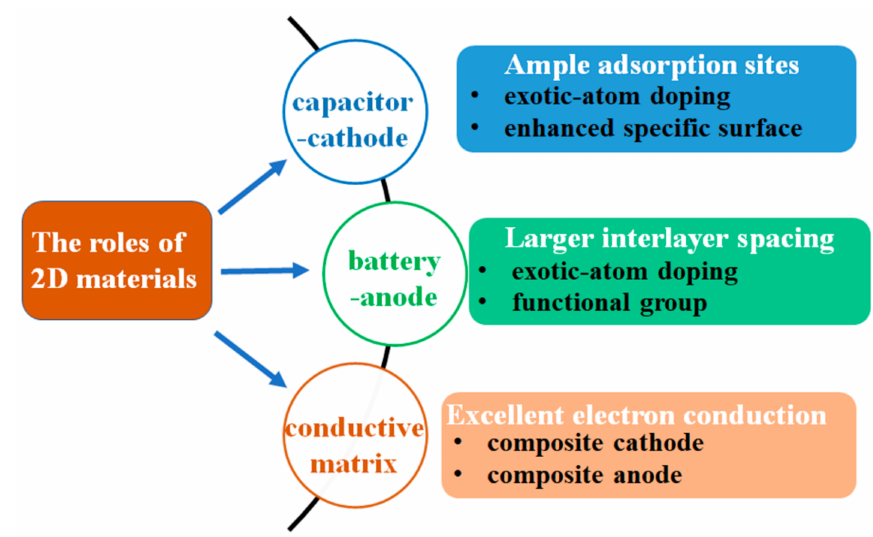
Figure 4. The roles of 2D carbon materials in hybrid